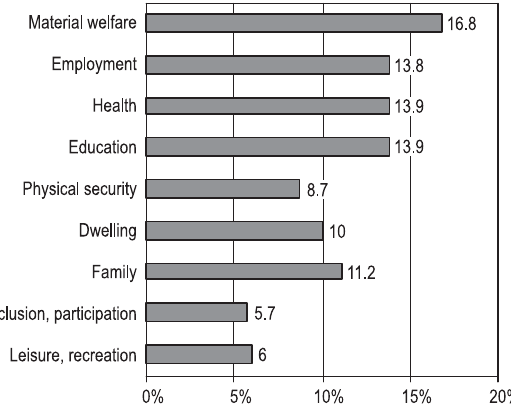
Fig. 9. QoL priorities for Latvians;